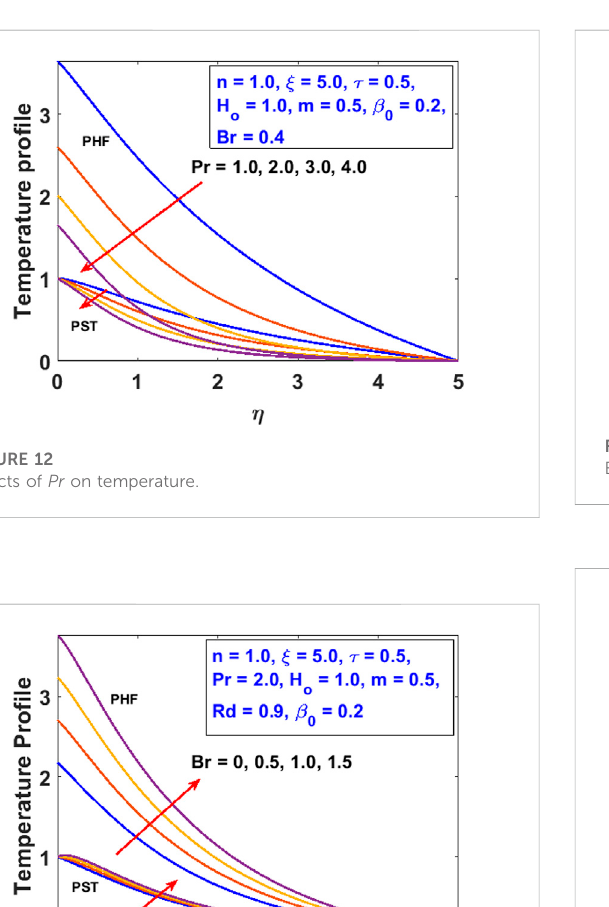
FIGURE 16 Effects of τ on temperature.